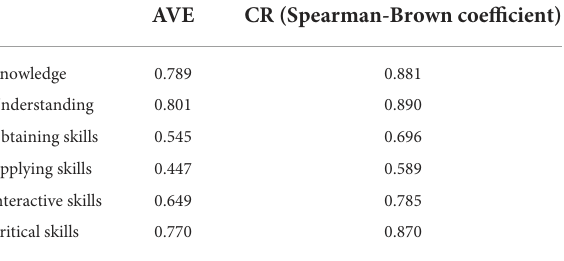
TABLE 6 Results of the correlation analysis between the dimensions and full-form